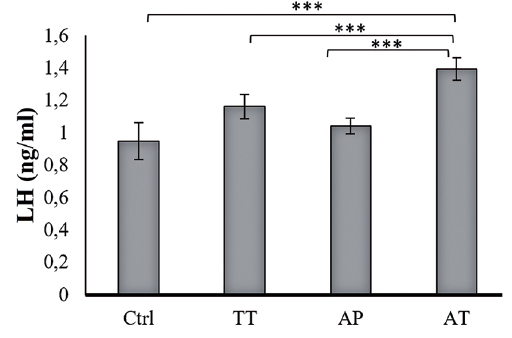
Figure 3- Effect of AP, TT and AT extract on serum level of LH (mean ± SD).